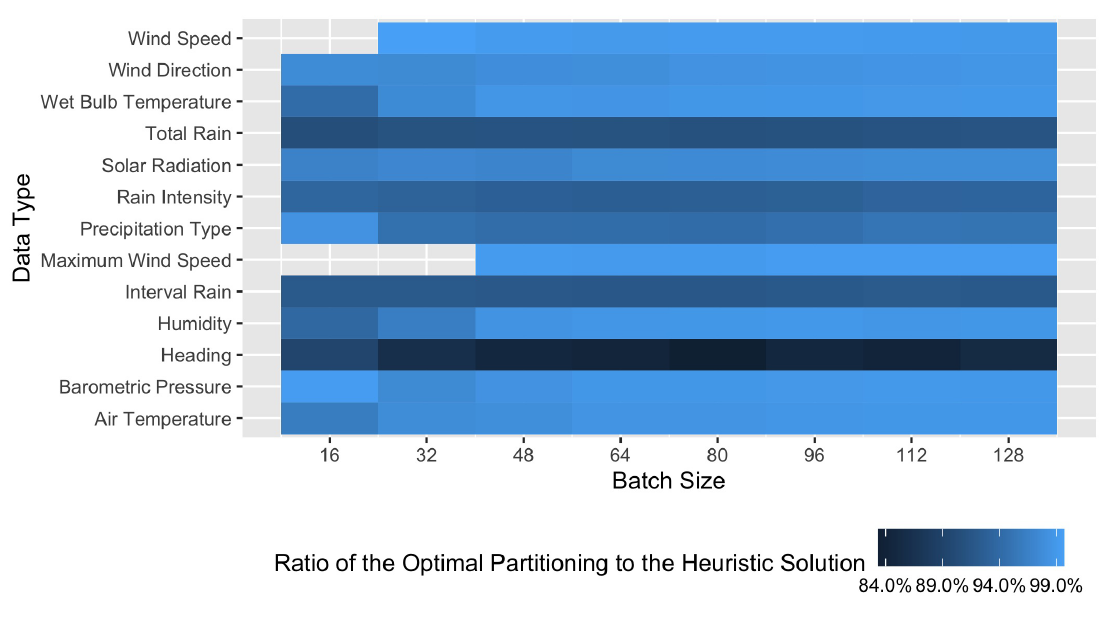
Figure 13. Ratio of optimal Rice coding considering partitioning versus the best heuristic partitioning solution found. The mean is calculated considering only those heuristic solutions for which the optimal could not be found, which account for 35% of the